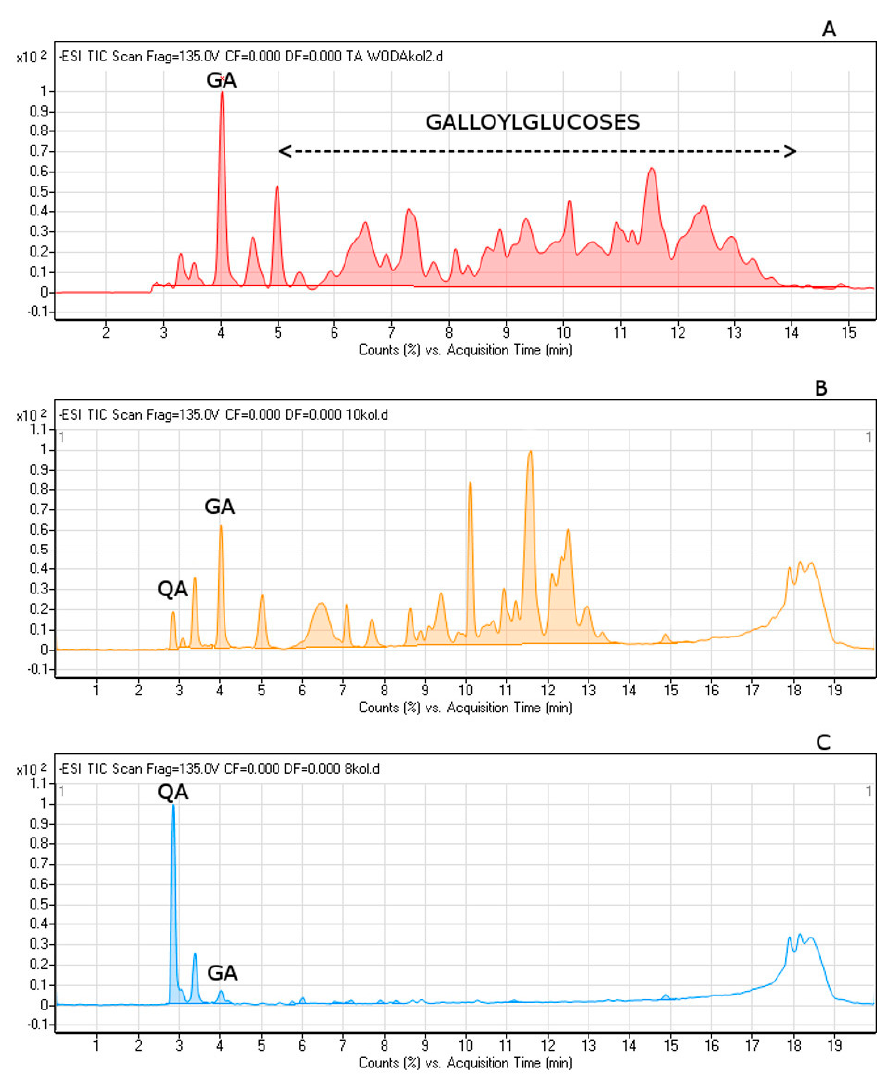
Figure 3. Chromatographic profiles obtained during the HPLC-MS SCAN ESI ( − ) analysis for the tannic acid ( A ) standard solution and gall nuts samples C. quercusfolii ( B ) and A. infectorius ( C ). GA, gallic acid, QA, quinic acid.